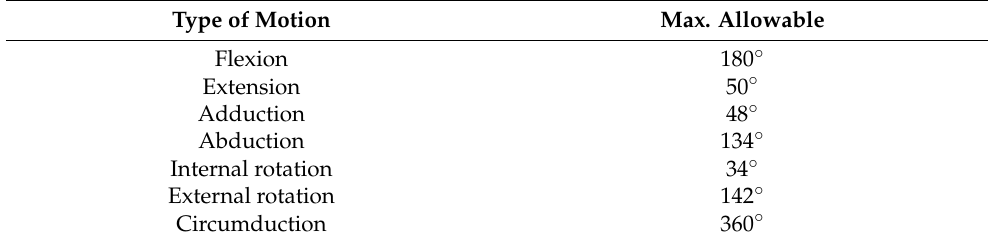
Table 3. Shoulder range of motion.